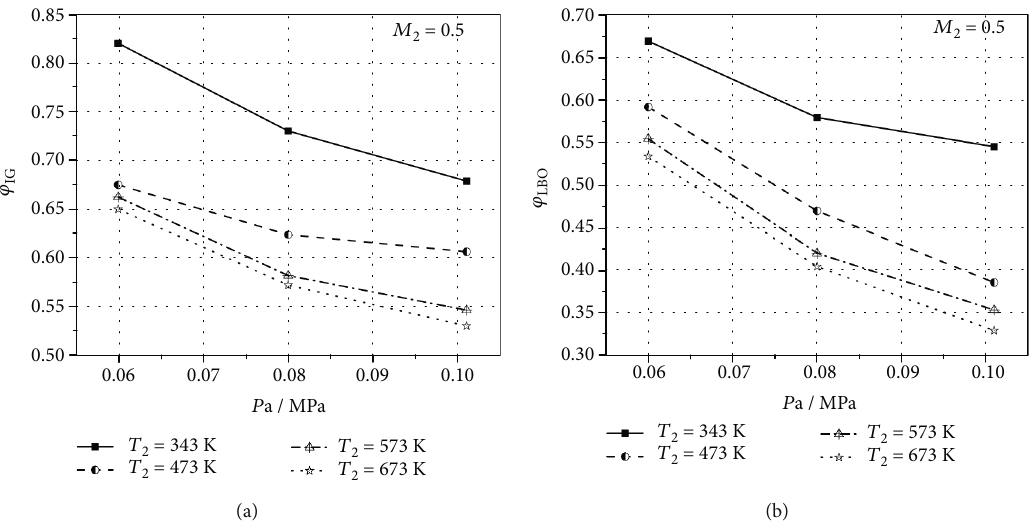
Figure 5: Lean ignition and lean blowout equivalence ratios of combustor with the various temperature at Ma blowout.